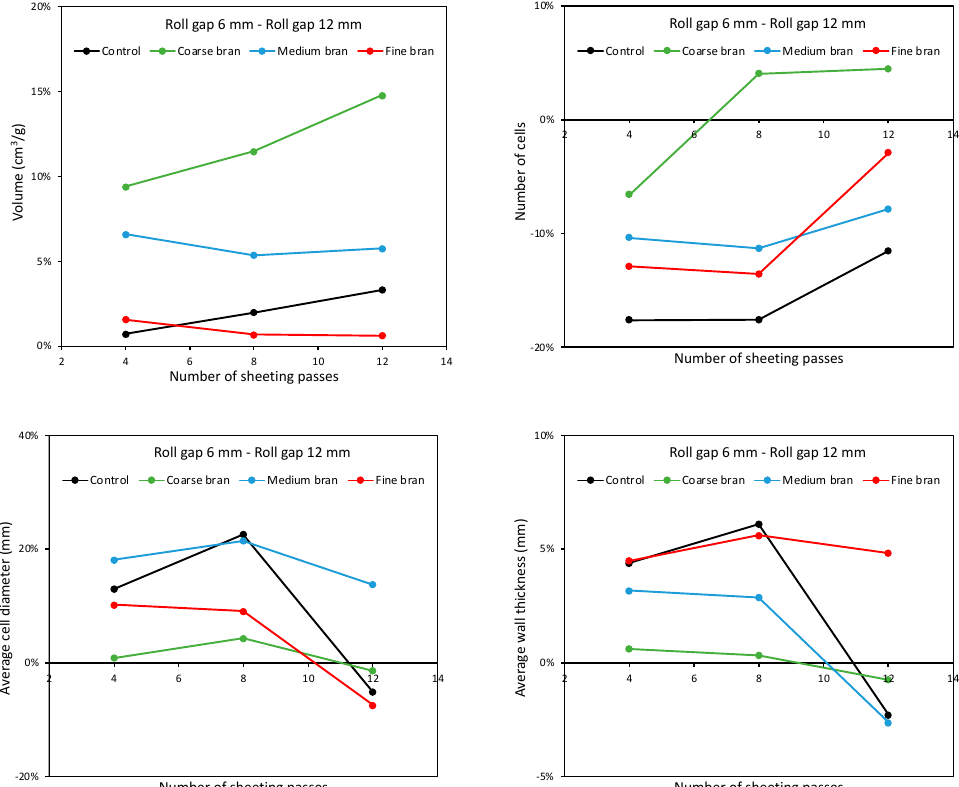
Figure 13. Percentage difference between sheeting at roll gaps of 6 and 12 mm, for loaf volume, average number of cells, average cell diameter and average wall thickness, for baked loaves containing 10% Fine, Medium and Coarse bran, sheeted for 4, 8 and 12 sheeting passes.